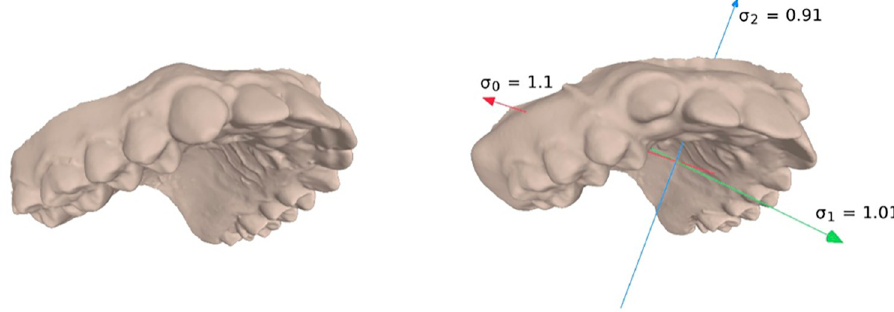
Fig 2. Target shape (left, post-treatment) and pre-treatment deformed shape with expansion directions and coefficients extracted from the affine matching matrix.